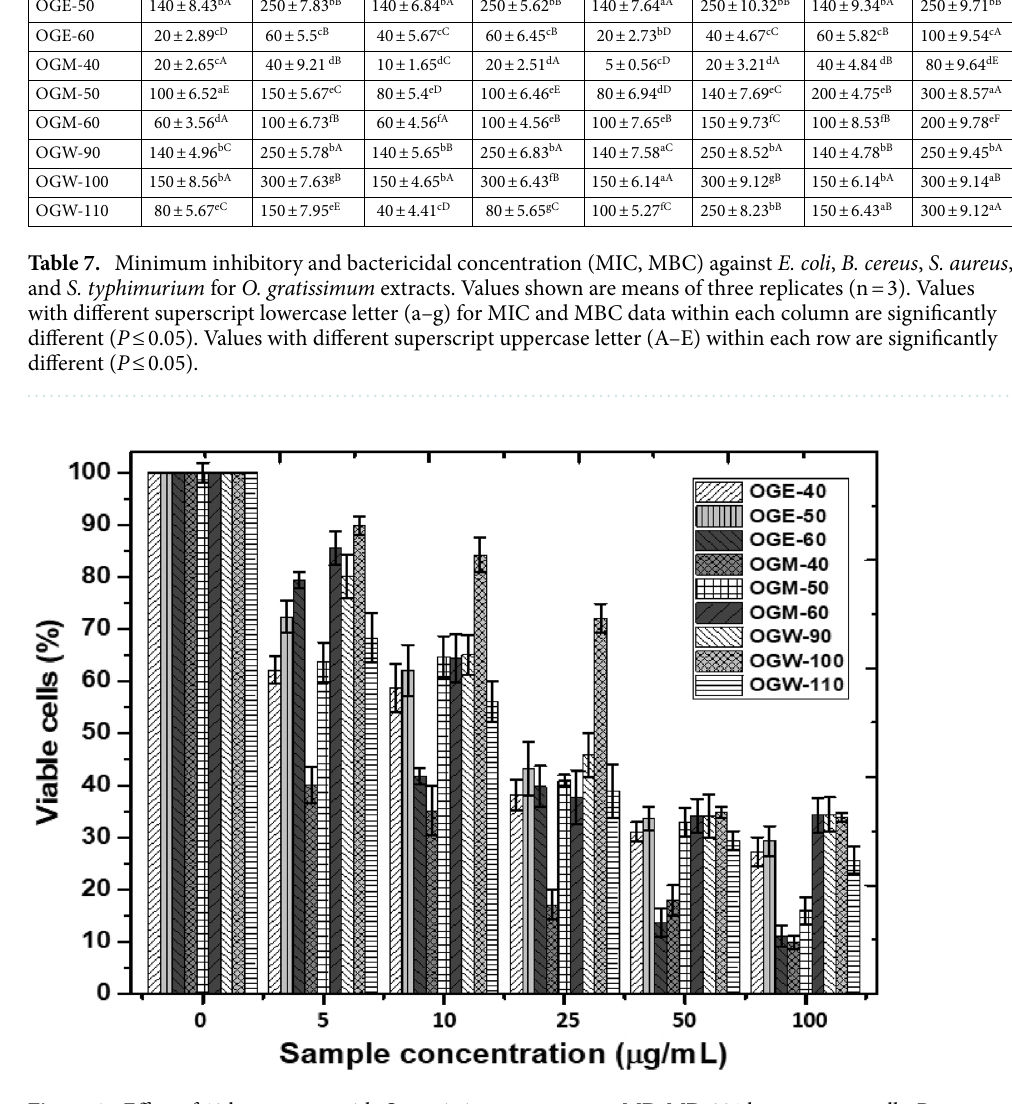
Figure 4. Effect of 48 h treatment with O. gratissimum extracts on MD-MD-231 breast cancer cells. Bars represent mean ± standard